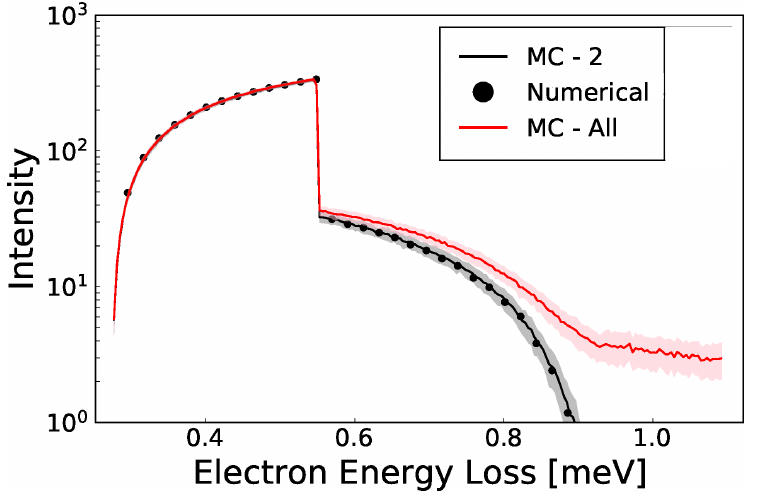
Figure A1. Comparison of the elastic peak in the EELS using a MC simulation including all collisions (red line), a MC simulation with 2 collisions (black line) and a Monte Carlo integration of 2 collisions (black dots). Shaded areas indicate the standard deviation of successive simulations. Resulting from single collisions, a large clear initial hump is present and consistent between all three models. A sharp drop-off followed by a decaying tail, then represents electrons that underwent multiple collisions. Excellent agreement was found between both the numerical and Monte Carlo